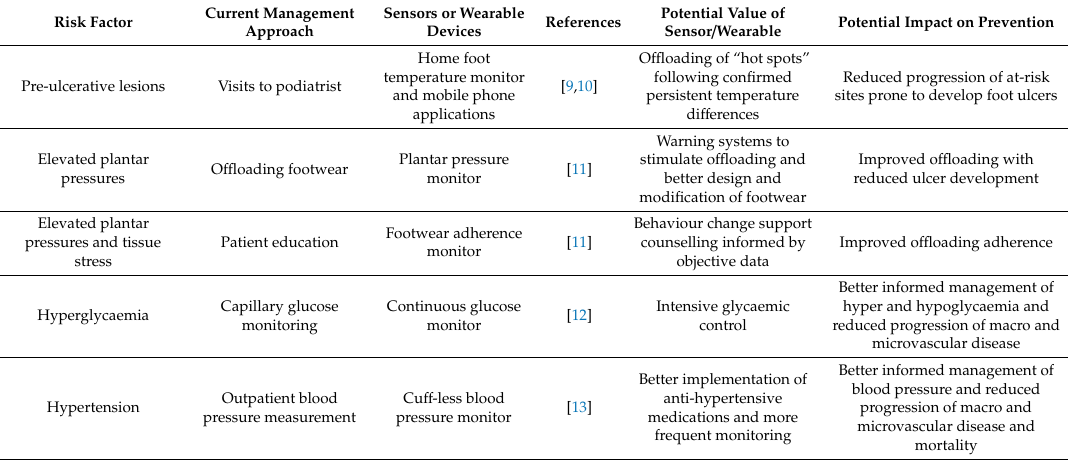
Figure 1. Key aspects of existing standard care compared with a future remote prevention program for diabetes-related foot disease. Legend: Comparison of existing in-person standard care of people with an at-risk foot (top care spectrum) compared with a future remote based management model (bottom care spectrum). The diagram outlines the key areas for prevention that can be targeted with sensors, wearables and telemedicine. Table 1. Examples of sensors and wearables with potential value for preventing